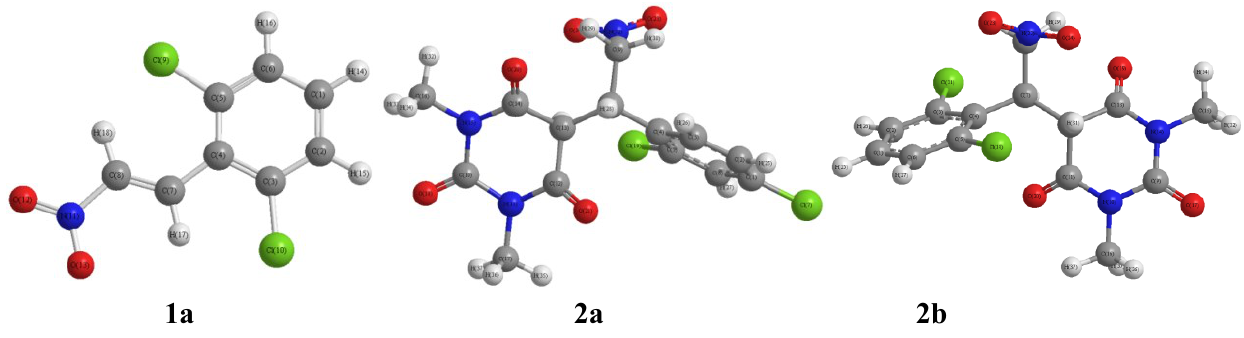
Figure 3. The optimized structures for 1a and 2a , b